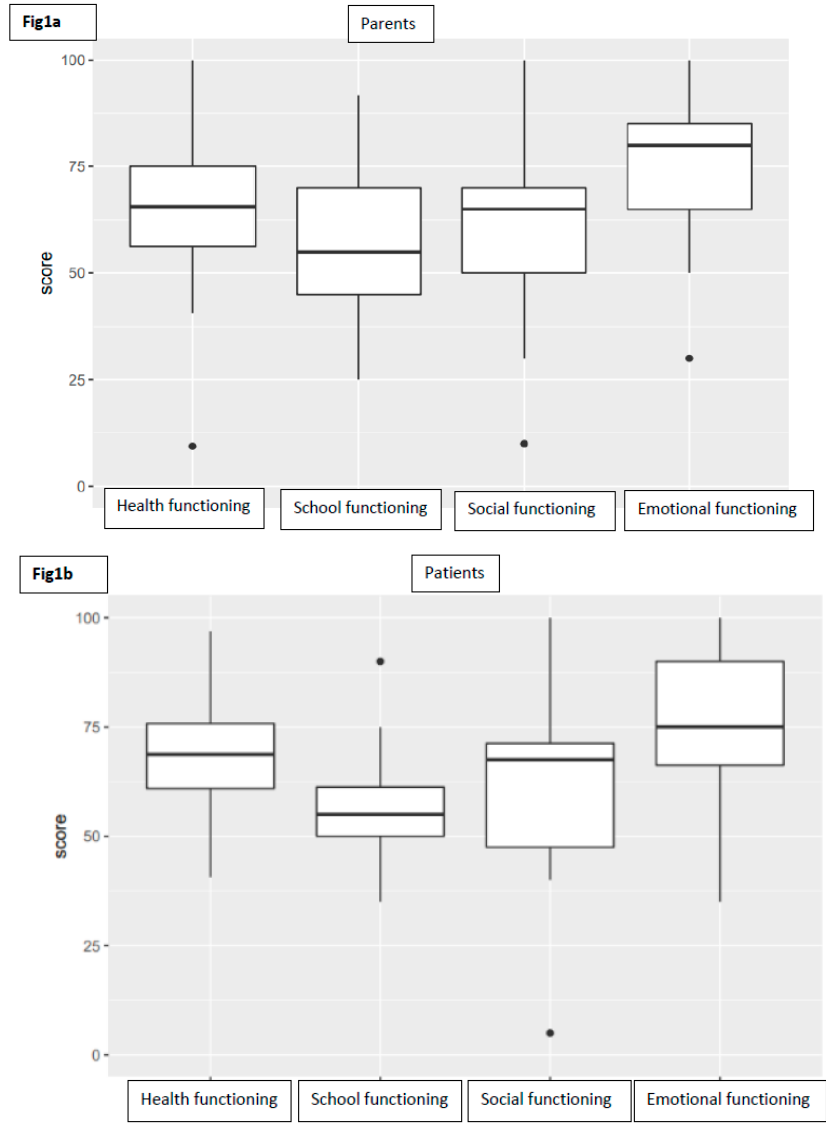
Figure 1. Boxplots representing the distribution of subscores of parents ( a ) and patients ( b ).